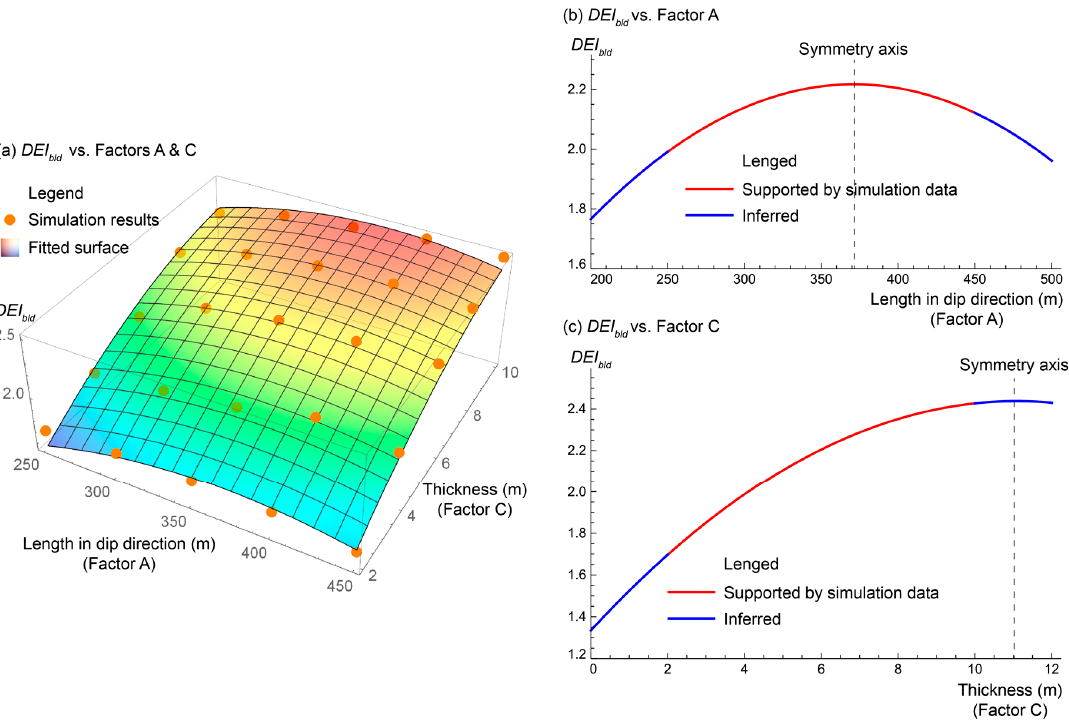
Figure 8. The relationship between the DEI bld and the length in dip direction (Factor A) and thickness (Factor C) of the coalface: ( a ) DEI bld vs. Factors A and C; ( b ) DEI bld vs. Factor A; ( c ) DEI bld vs. Factor C.